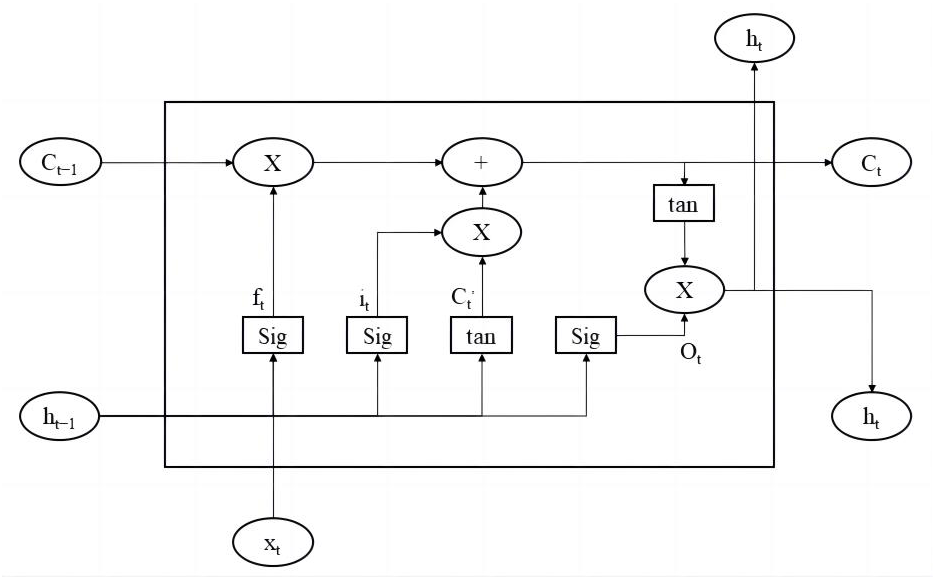
Figure 1. LSTM neural network structure.